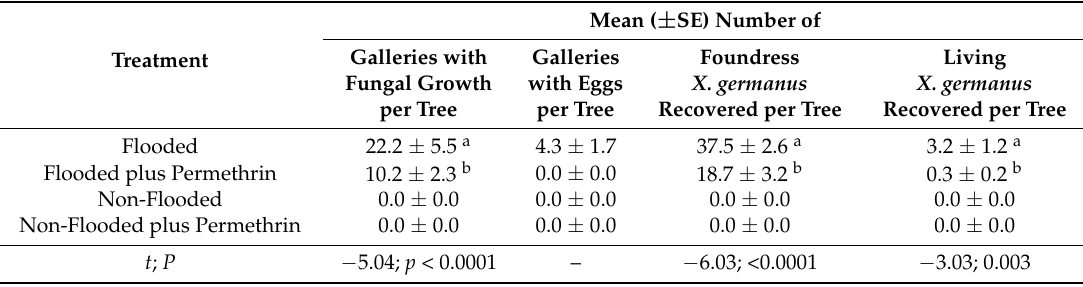
Table 1. Influence of flooding and preventive insecticide treatment on attacks and colonization success of ambrosia beetles in C. canadensis deployed in